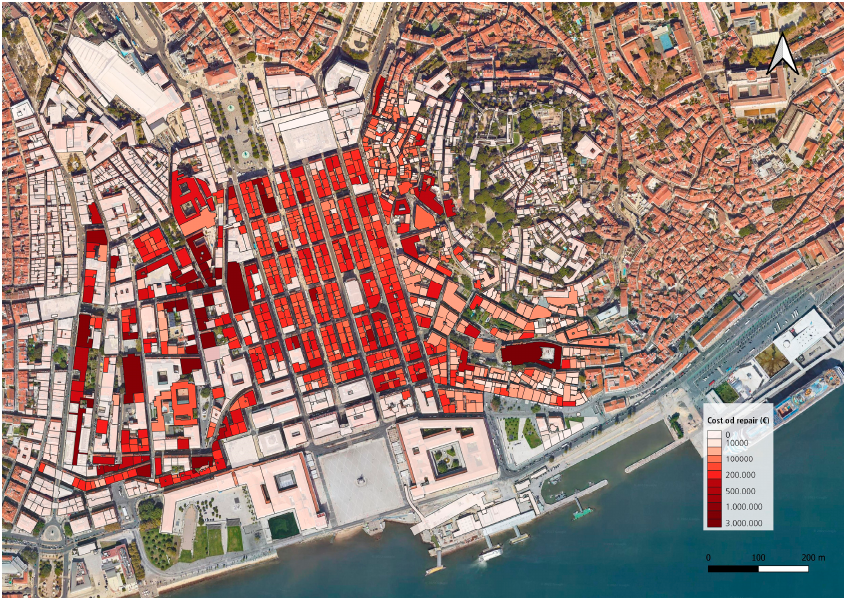
Figure 14. Cost of repair of Lisbon downtown (€).